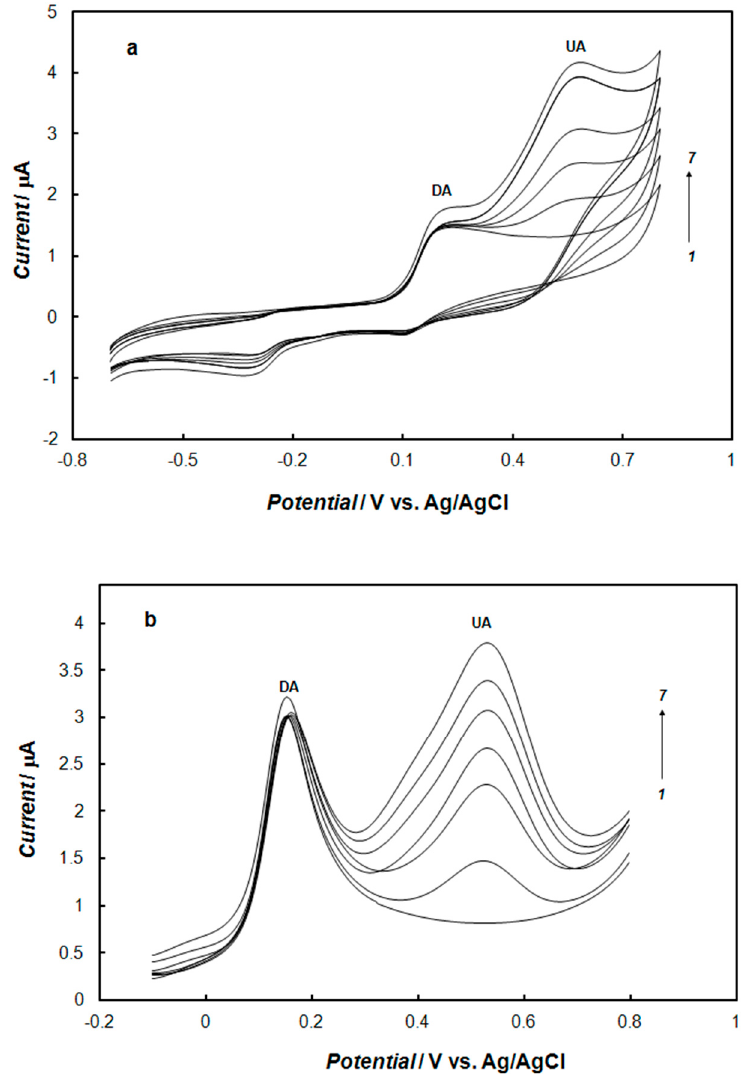
Figure 11. Cyclic ( a ) and square-wave ( b ) voltammograms recorded at the gold electrode modified with the nanocomposite of polypyrrole—MCM-48 in 0.1 M of phosphate buffer solution (pH 7.4) containing 0.1 mM of dopamine, and uric acid with concentrations: ( 1 ) 0 mM, ( 2 ) 0.1 mM, ( 3 ) 0.2 mM ( 4 ) 0.3 mM, ( 5 ) 0.4 mM, ( 6 ) 0.5 mM, and ( 7 ) 0.6 mM. The potential sweep rate was 0.1 V s − 1 . The square wave amplitude was 25 mV, frequency was 25 Hz, and step potential was 4 mV.